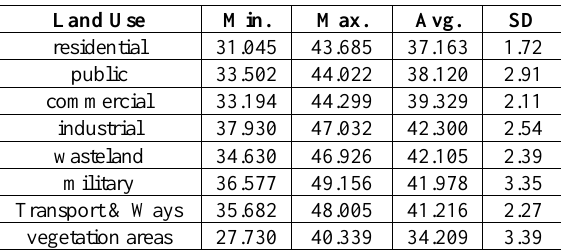
Table 4. Summary temperature results for the land